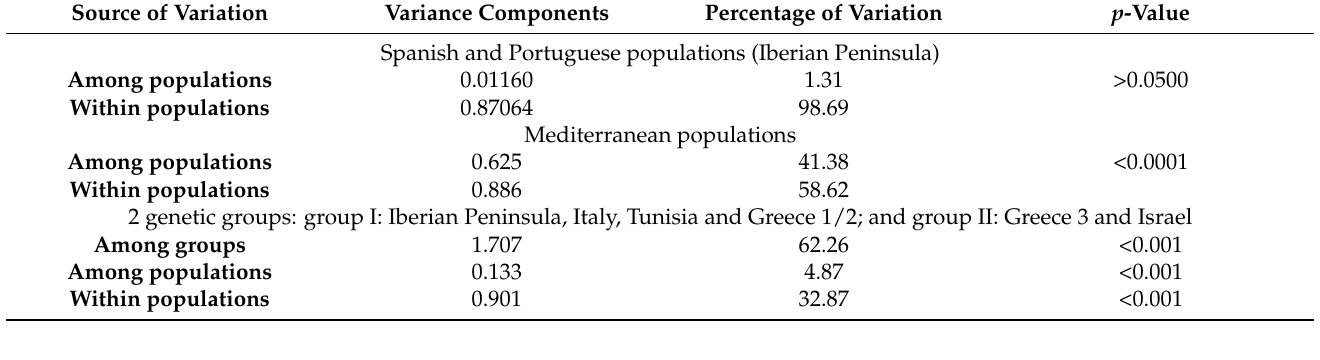
Table 3. Analysis of molecular variance (AMOVA). The molecular variance was estimated among populations, among populations within groups and within populations.